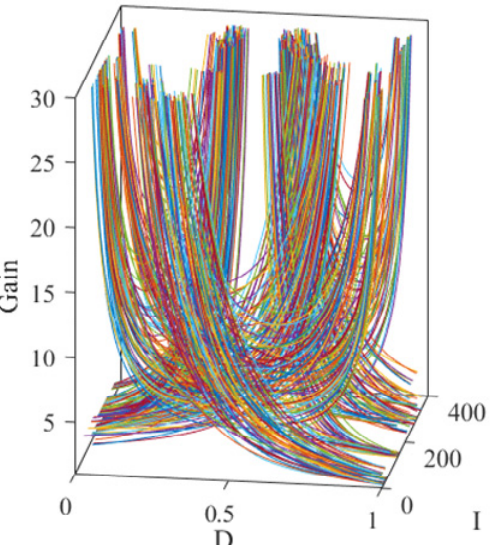
Figure 3. All possible gain curves that must have a boost capability in the duty cycle range of 0 < D < 1.